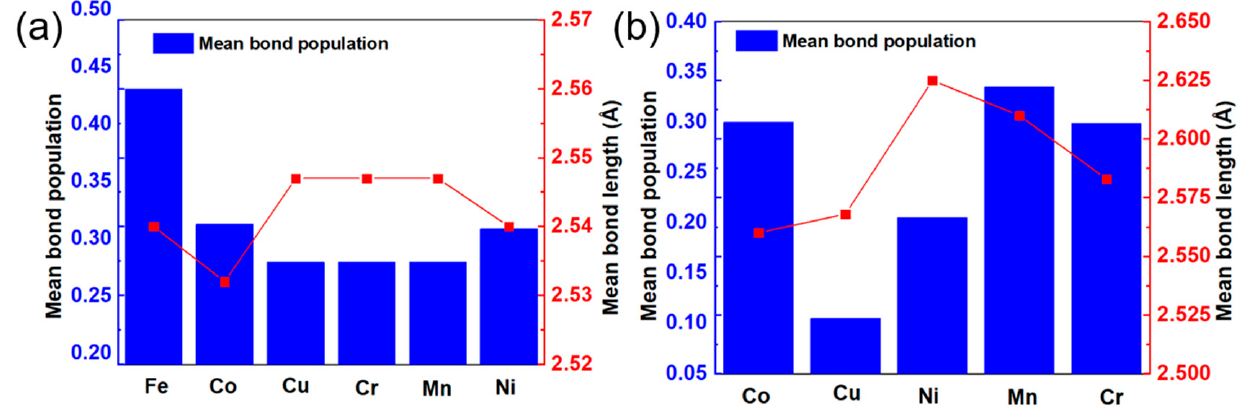
Figure 6. The average bond length and average bond population of Al-Fe bonds ( a ) and Al-M bonds ( b ) in Al 13 (Fe,M) 4 .